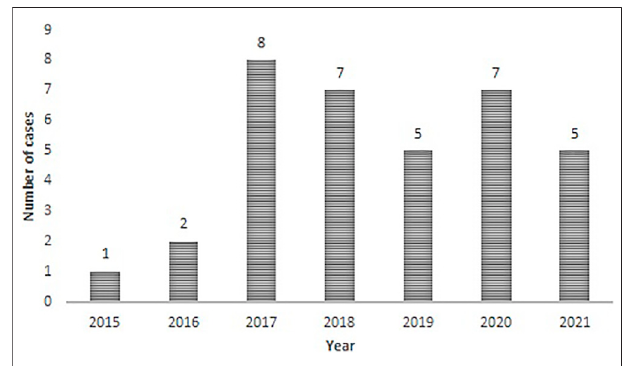
FIGURE 1 | Number of PCI cases analyzed between 2015 and